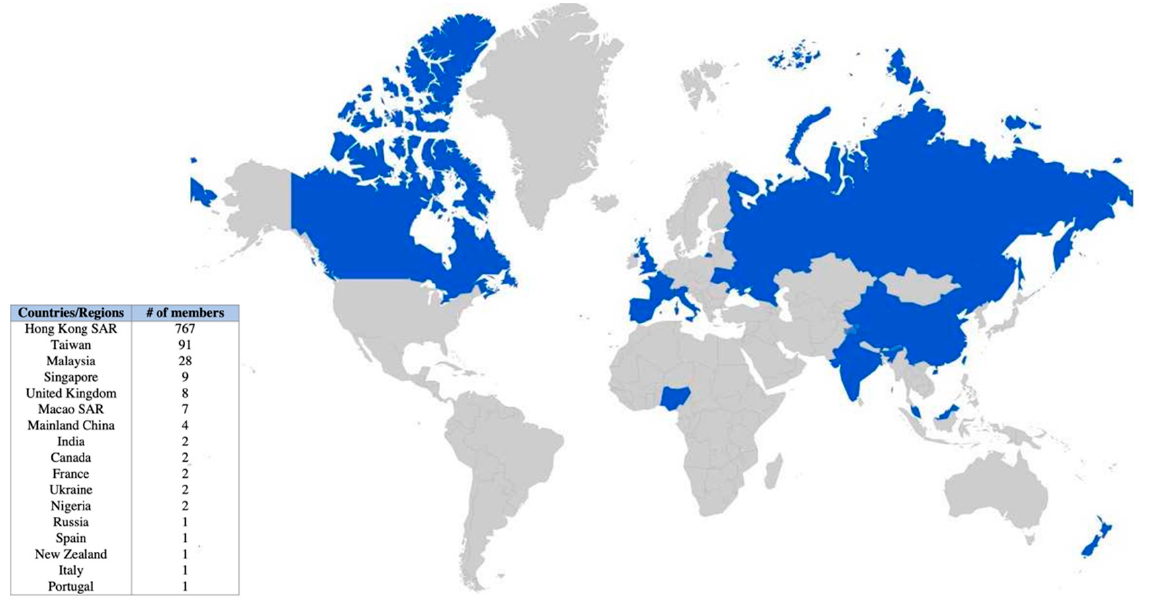
Figure 5. Locations of Caritas Aberdeen IFSC’s “Zen Ring” Facebook group members.